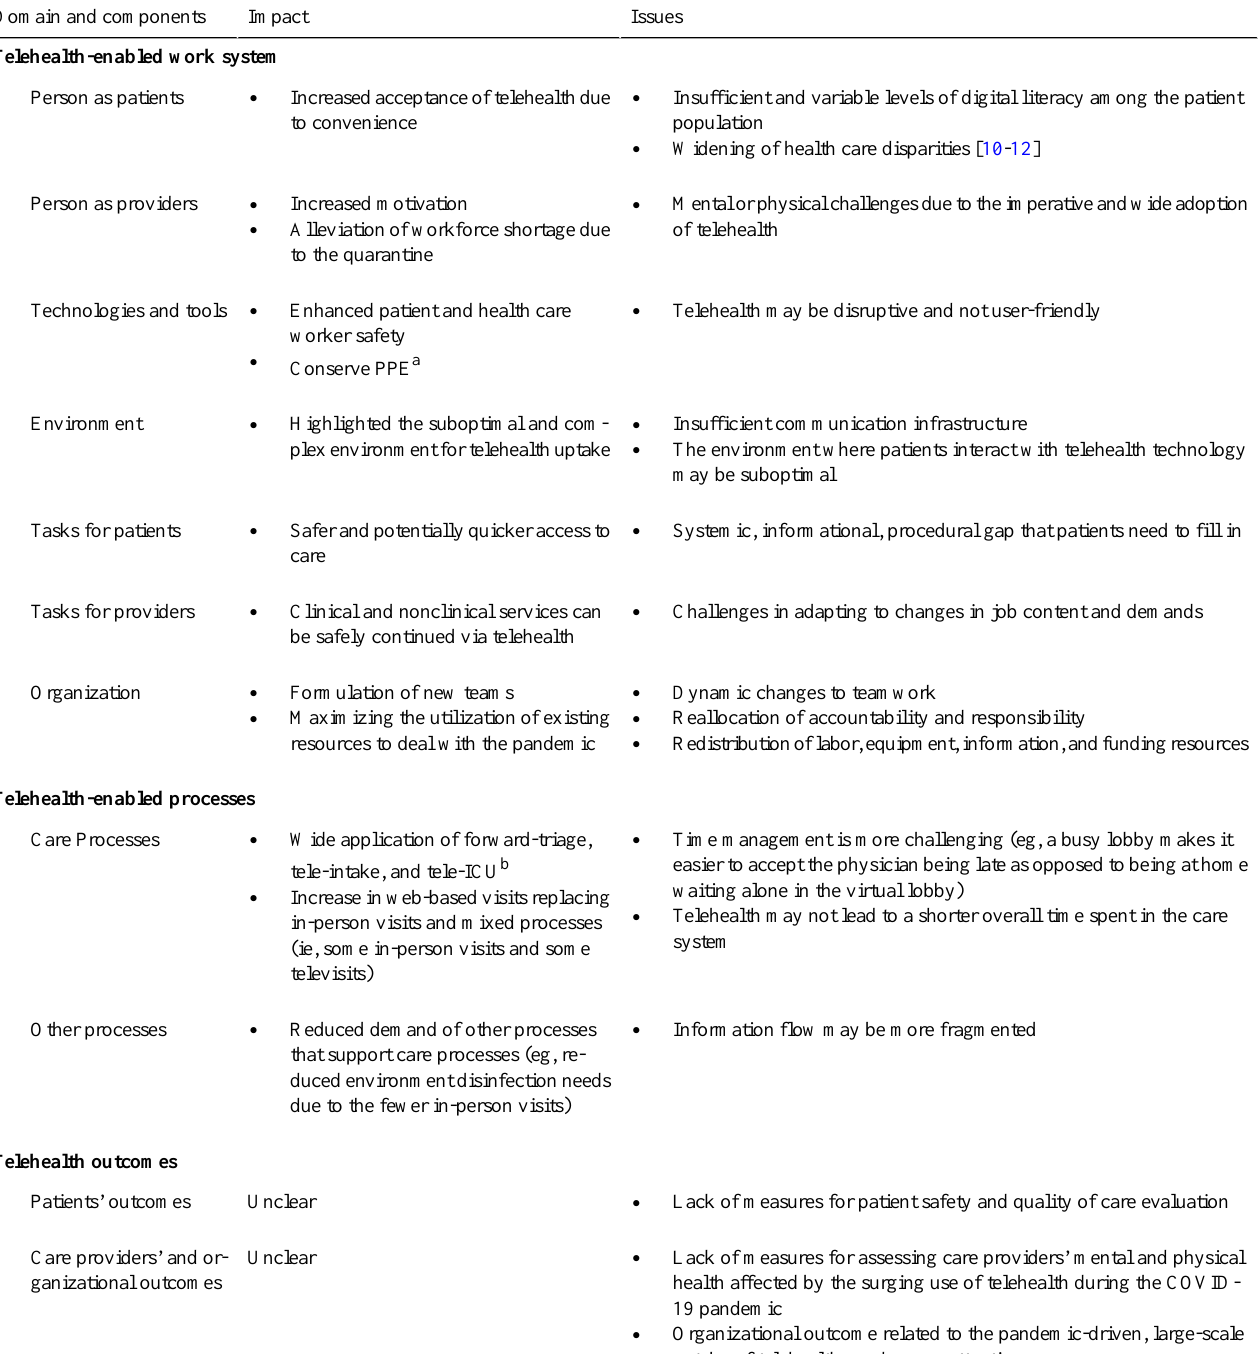
Table 1. Assessment of barriers related to and impact of telehealth implementation during the COVID-19 pandemic by using the Systems Engineering Initiative for Patient Safety (SEIPS)